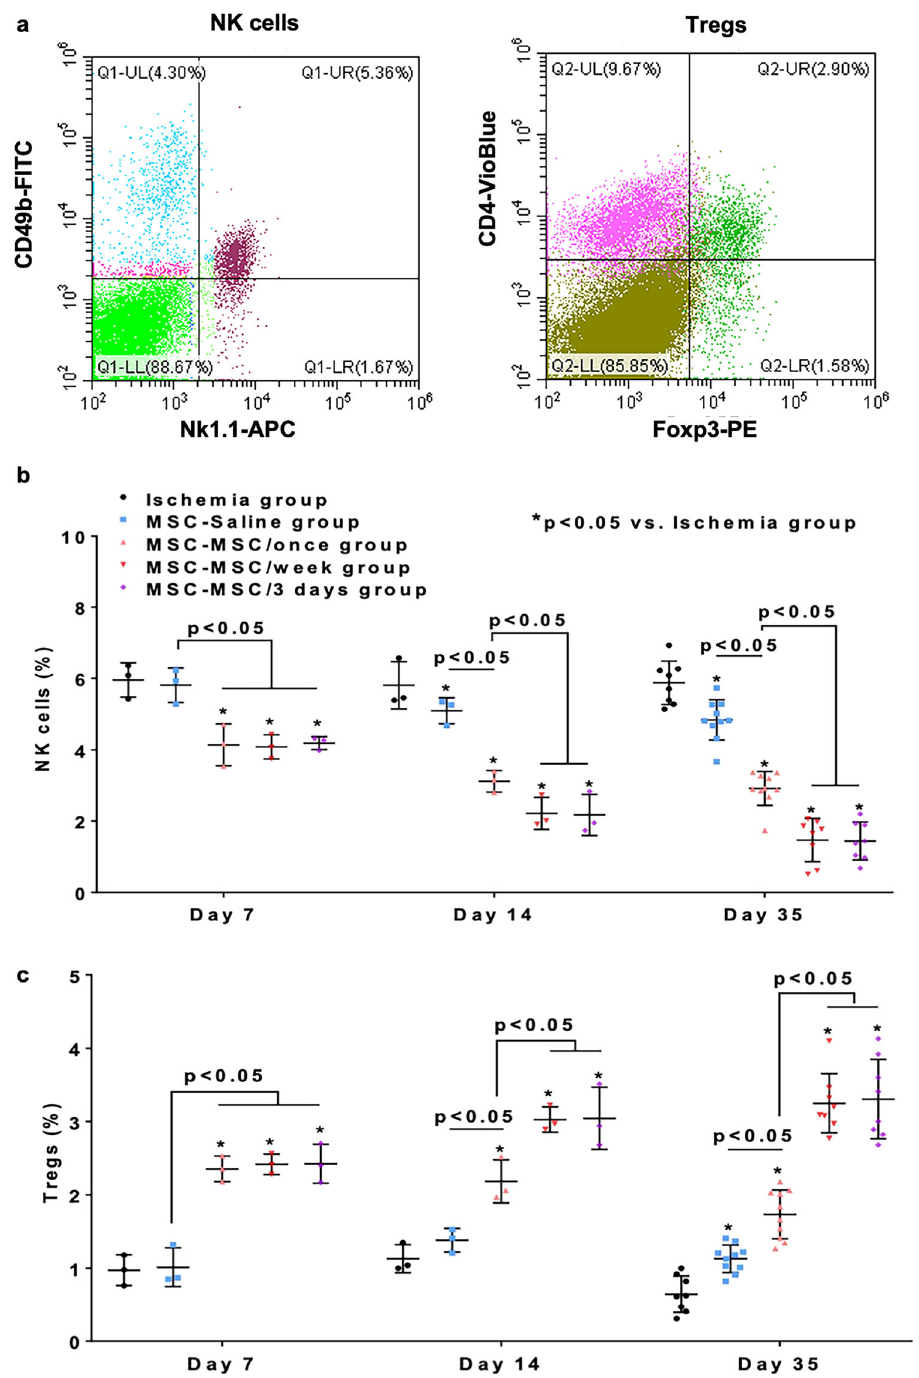
Fig. 8 Repeated intravenous administration of hiPSC-MSCs reduced splenic NK cells and increased splenic Tregs. Splenic Tregs and NK cells were determined by fl ow cytometry analysis at day 7, 14 and 35 ( a ). After intramuscular transplantation of hiPSC-MSCs, splenic NK cells were signi fi cantly decreased in the MSC-Saline, MSC-MSC/once, MSC-MSC/week and MSC-MSC/3 days groups from day 14 onwards compared with the ischemia group (all p < 0.05). A single or repeated intravenous hiPSC-MSC infusion in the MSC-MSC/once, MSC-MSC/week and MSC-MSC/3 days groups signi fi cantly decreased splenic NK cells from day 7 onwards compared with the ischemia and MSC-Saline groups (all p < 0.05). Repeated intravenous hiPSC-MSC infusion in the MSC-MSC/week and MSC-MSC/3 days groups further decreased splenic NK cells from day 14 onwards compared with the MSC-MSC/ once group (all p < 0.05) ( b ). After intramuscular transplantation of hiPSC-MSCs, splenic Tregs were signi fi cantly increased in the MSC-Saline, MSC- MSC/once, MSC-MSC/week and MSC-MSC/3 days groups at day 35 compared with the ischemia group (all p < 0.05). A single or repeated intravenous hiPSC-MSC infusion in the MSC-MSC/once, MSC-MSC/week and MSC-MSC/3 days groups signi fi cantly increased splenic Tregs compared with the ischemia and MSC-Saline groups (all p < 0.05). Moreover, repeated intravenous hiPSC-MSC infusion in the MSC-MSC/week and MSC-MSC/3 days groups further increased splenic Tregs from day 14 onwards compared with the MSC-MSC/once group (all p < 0.05) ( c